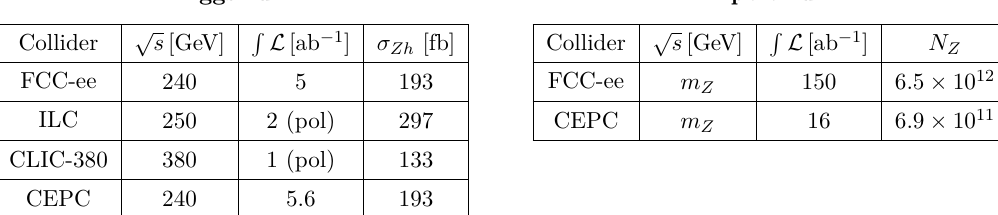
Table 5 . Center-of-mass energies and total integrated luminosities for the various collider options considered in the analysis for Higgs runs (left) and Z pole runs (right). For the Higgs runs we report the values of the Higgs-strahlung cross-section reported in [52], while for the Z pole runs the number of expected Z bosons produced with the corresponding integrated luminosity from